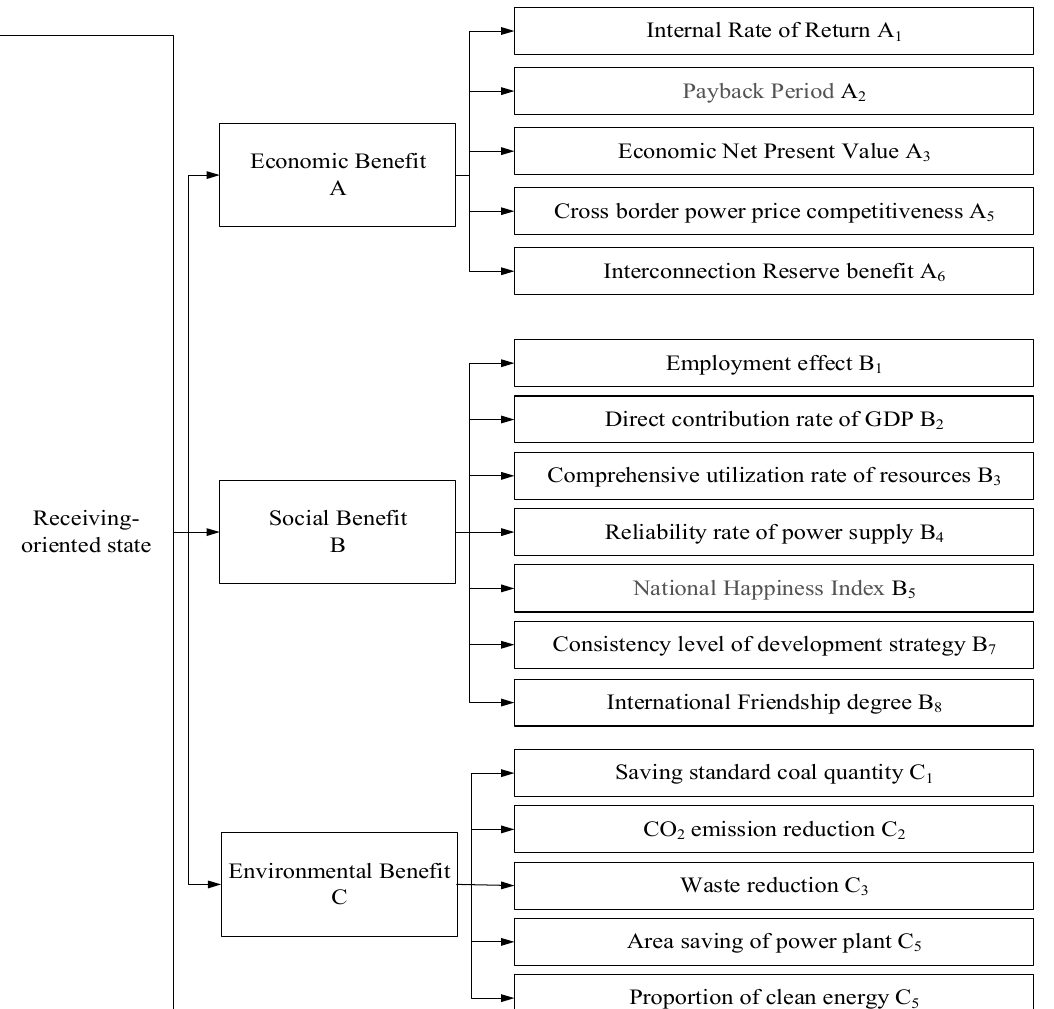
Figure 5. The comprehensive benefit evaluation index system of transnational power networking projects based on the perspective of receiving-oriented states.